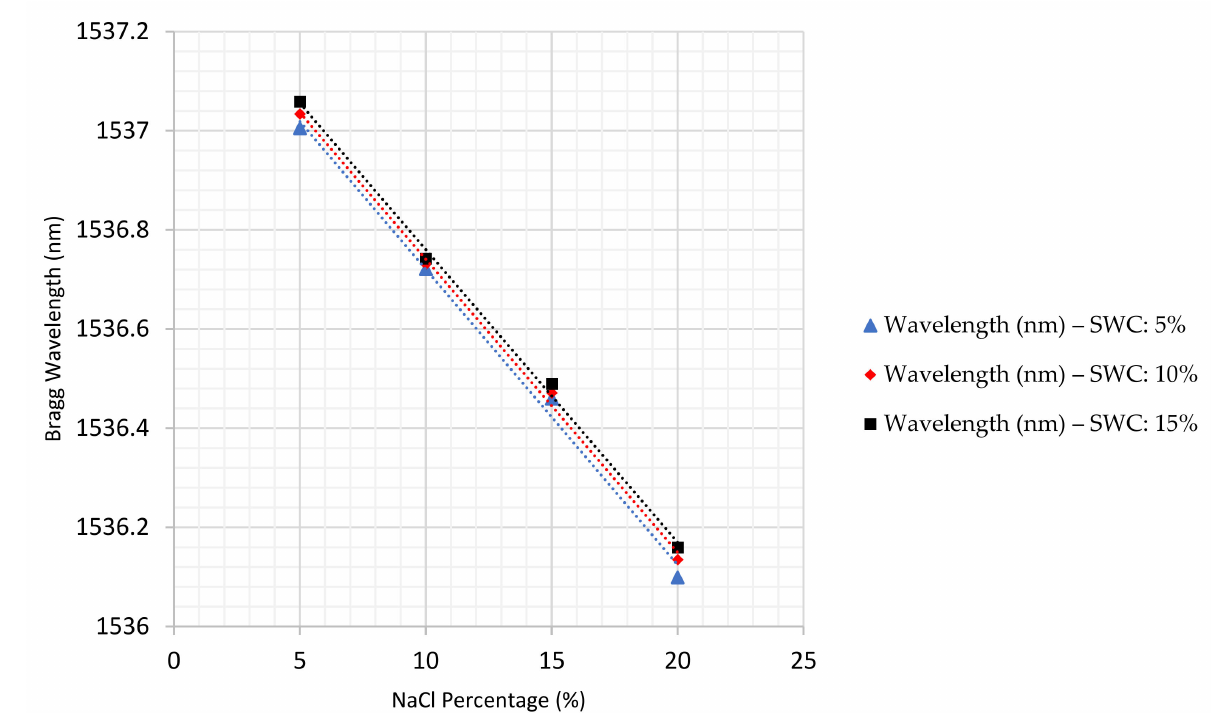
Figure 15. Comparison of salt concentrations at 5%, 10% and 15% soil water content.